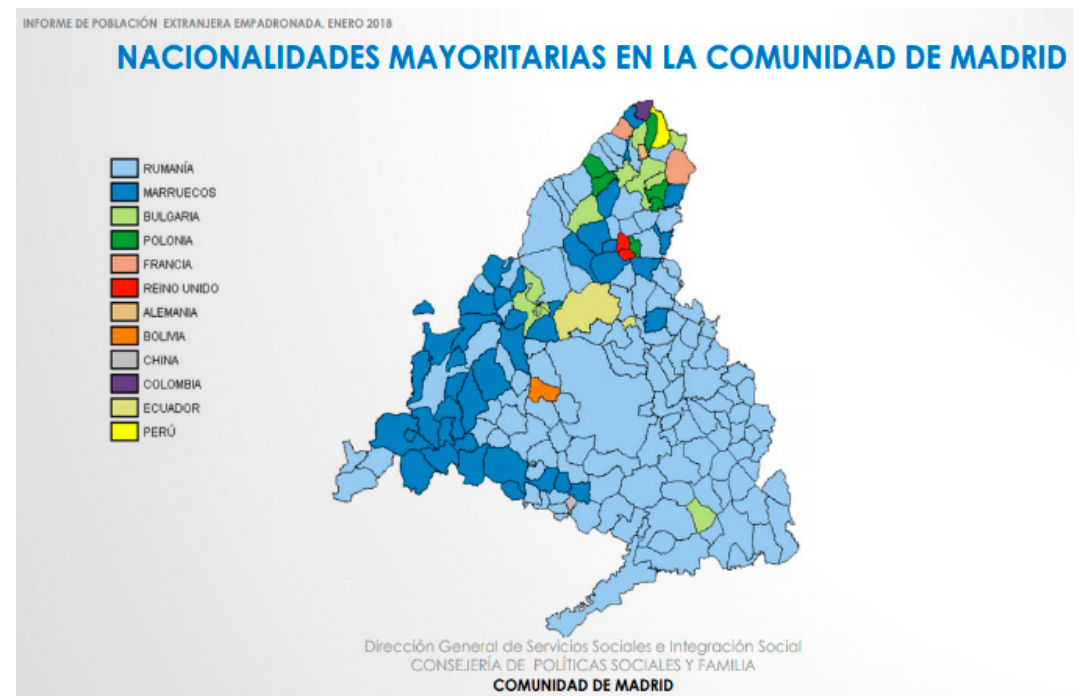
Figure 1. Map of the majority nationalities of the foreign population in the Community of Madrid, by town (Immigration Observatory–Research and Data Centre 2018).